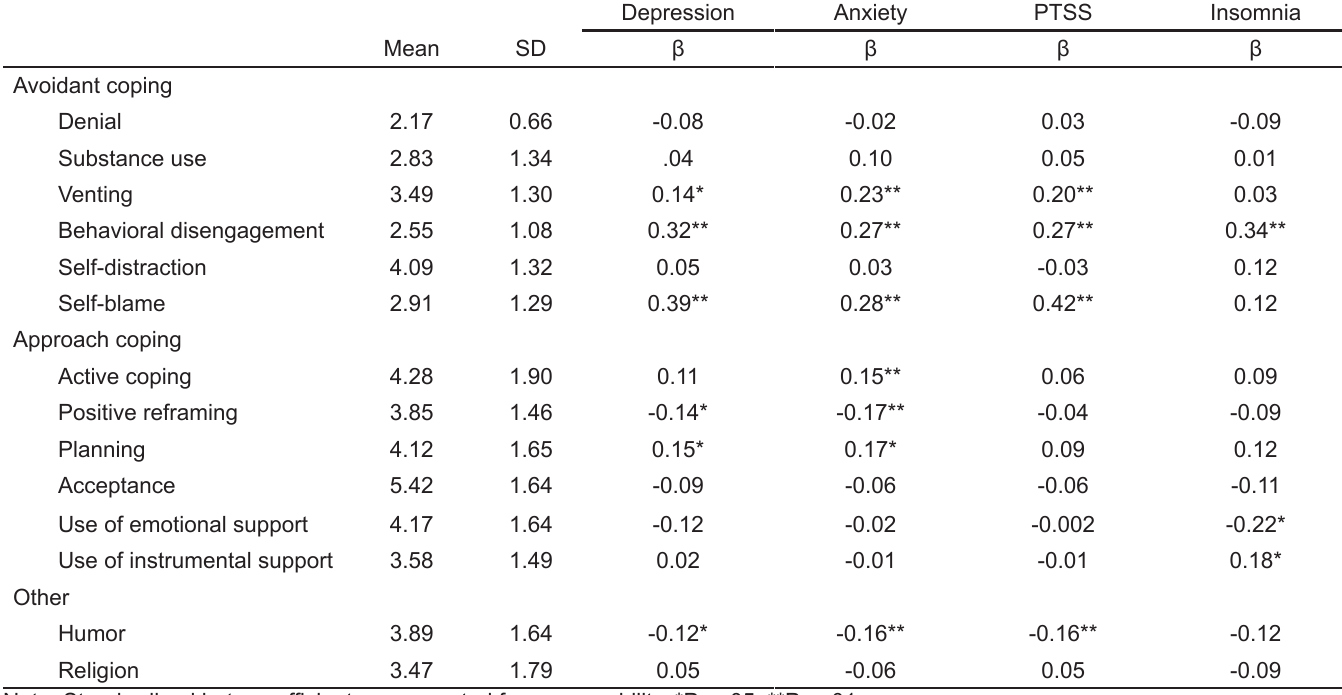
Table 7. Multiple regression analyses for coping variables predicting mental health